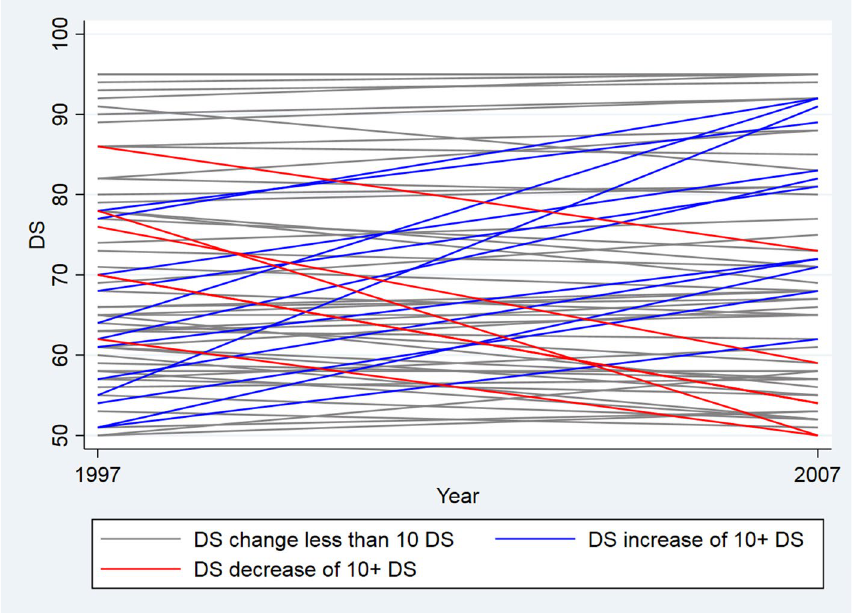
Figure 2. Longitudinal change in degree of skewed X-chromosome inactivation (DS) plotted at baseline in 1997 and follow-up in 2007 twin women (N = 67) from the LSADT